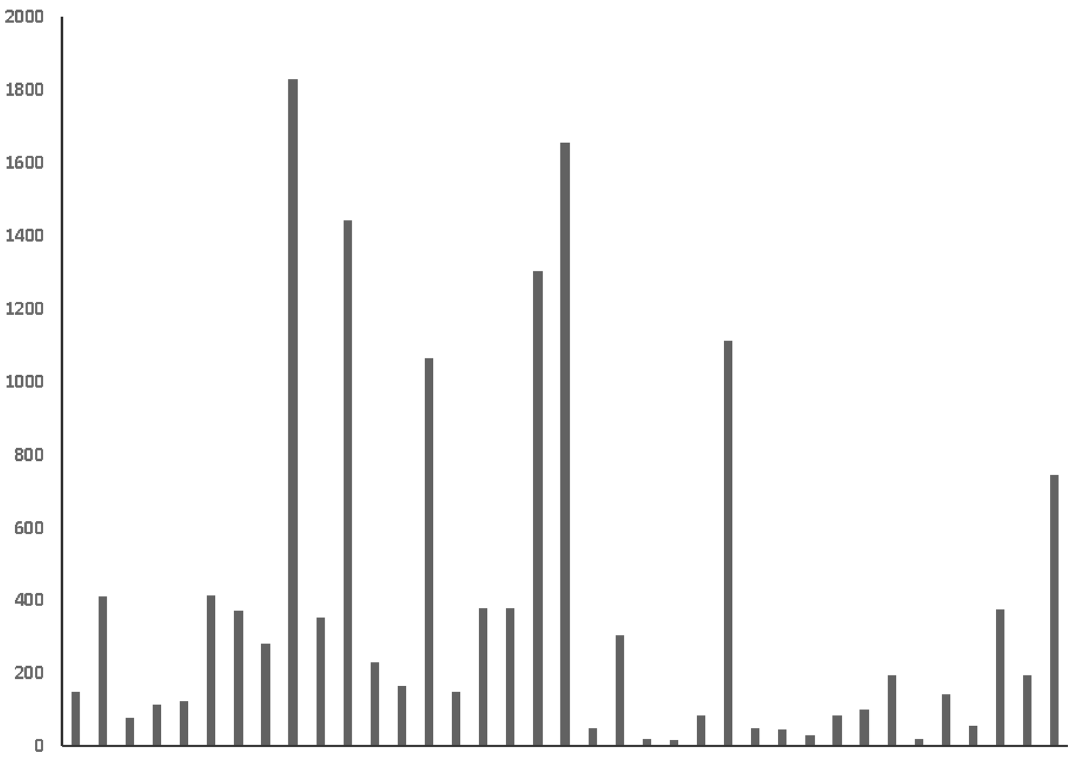
Figure 4. Number of